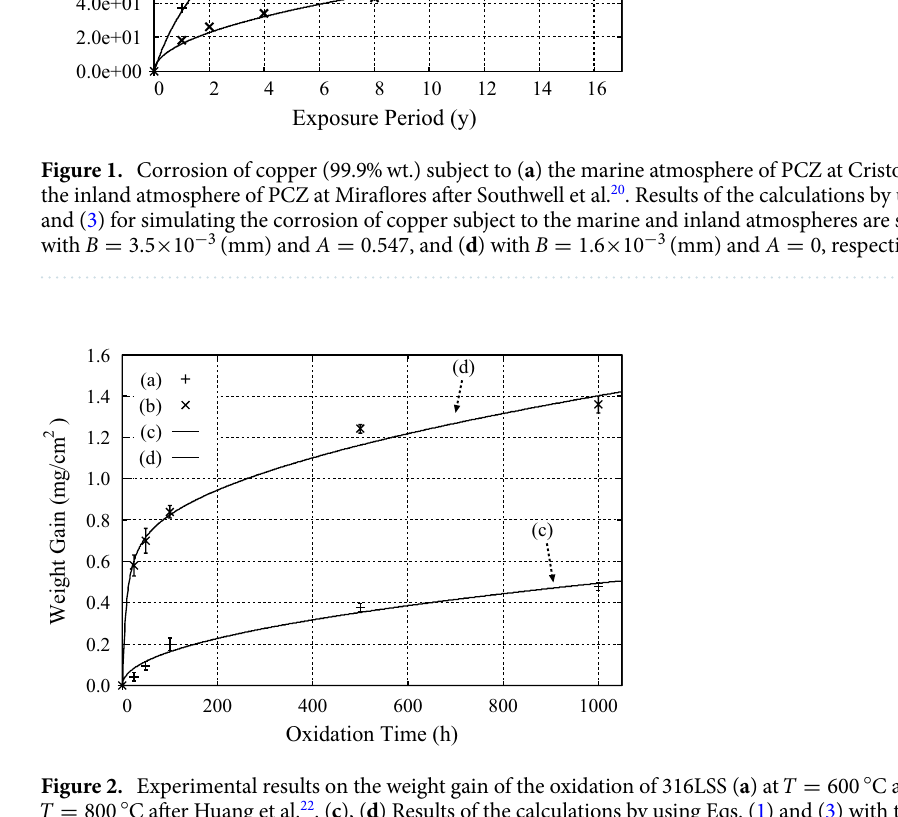
0.28 at T 600 ◦ C, and ( d ) B = =